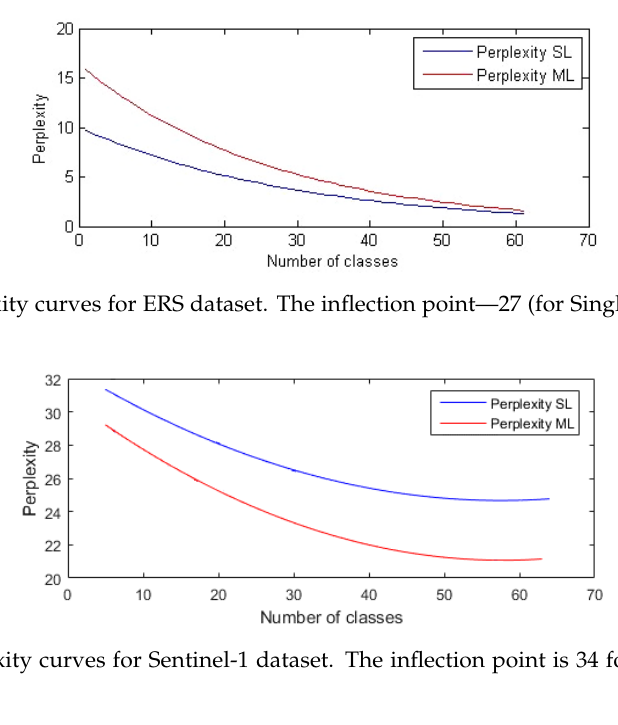
( C ) Figure 13. Multi-look Sentinel-1 image amplitude, Constanta ( A ); Scene classification map presenting categories of evolution ( B ); spatial distribution of detected Persistent Scatterers ( C ). 5.3. 3rd Experiment — An Analytical Approach to Highlight the PS’s Temporal Character For this analysis, we vary only the parameter representing the number of classes (from 3 to 61) and preserve the same values for all the rest when running the LDA algorithm. A low perplexity indicates that the probability distribution is good for the corresponding number of classes. We